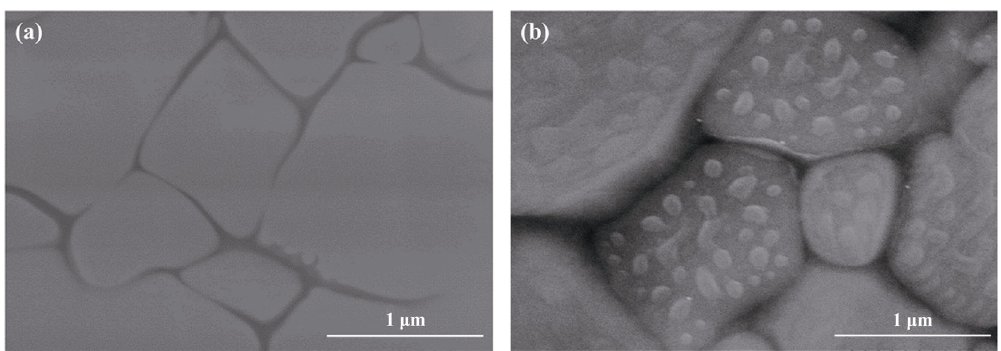
Fig. 7 SEM images of equiaxed grains in Al 2 O 3 –YSZ coatings (a) before and (b) after thermal cycles.